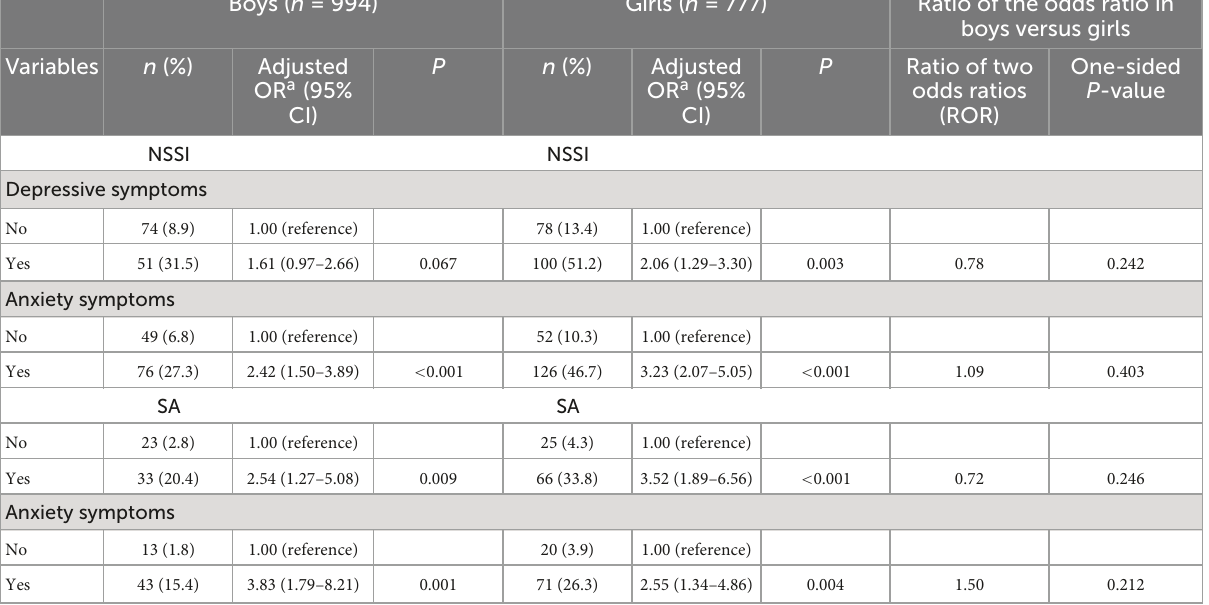
TABLE 3 Frequencies, prevalence, and odds ratio of depressive and anxiety symptoms by NSSI or SA in girls and boys, and the gender ratio. Boys ( n = 994) Girls ( n = 777) Ratio of the odds ratio in boys versus girls